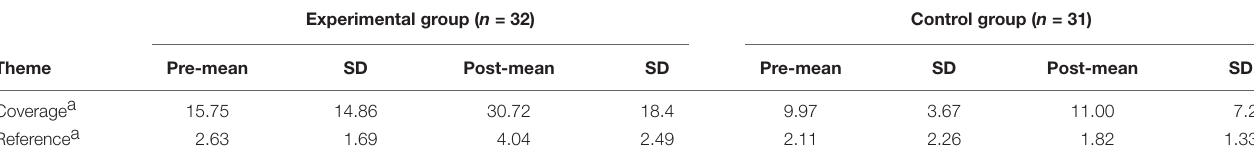
TABLE 1 | Pre- and post-test critical